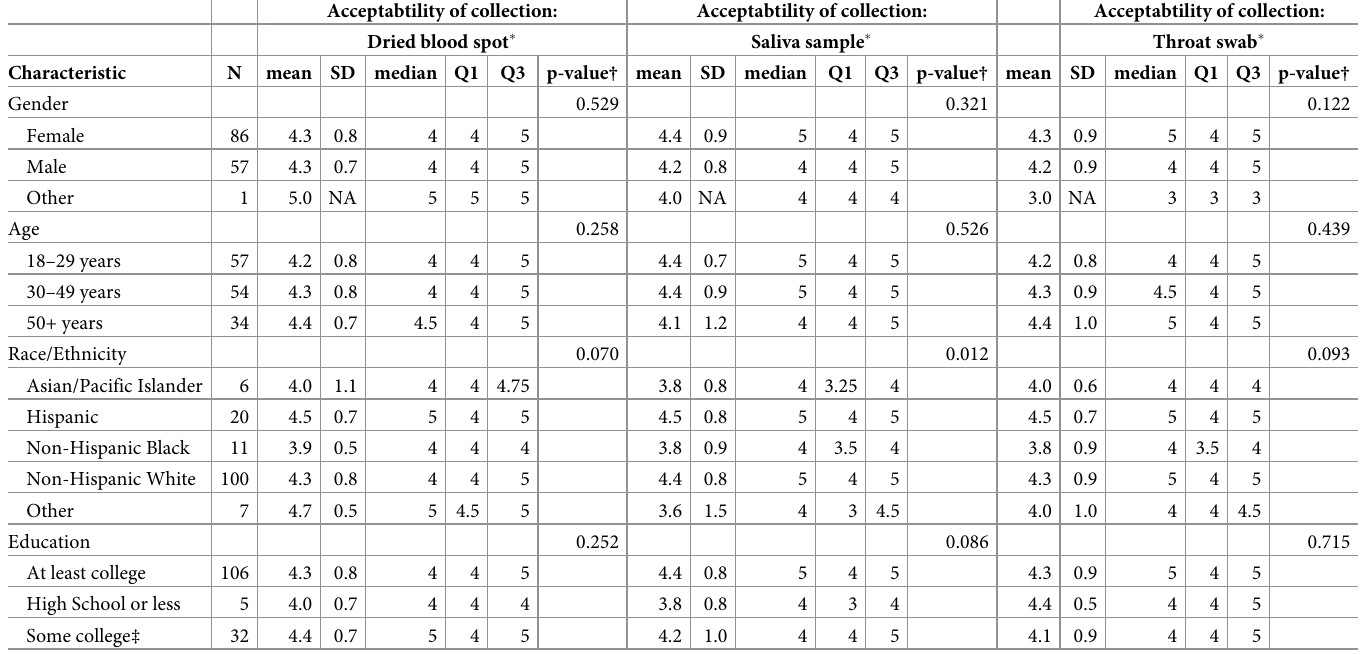
Table 1. Acceptability of at-home self-collection of dried blood spot, saliva and oropharyngeal swab specimens for SARS-CoV-2-related testing after specimen col- lection, by gender, age, race/ethnicity, and education, United States, April 2020. Acceptabtility of collection: Acceptabtility of collection: Acceptabtility of collection: